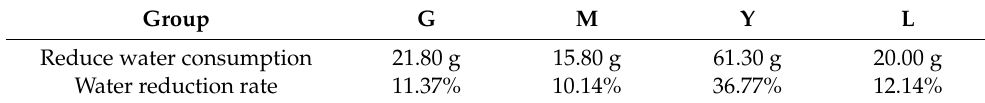
Table 3. Water-reducing effect of water reducer on four clay mineral paste systems.